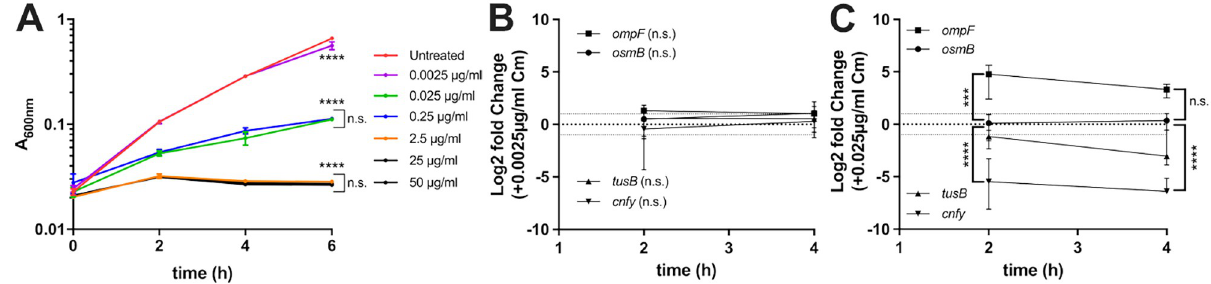
Fig 8. ompF , tusB , and cnfy are differentially regulated in response to inhibitory concentrations of chloramphenicol, while osmB expression was only altered by doxycycline. (A) WT Y . pseudotuberculosis was grown in the presence of the indicated concentrations of chloramphenicol (Cm). Growth was measured by absorbance (A 600nm ) at the indicated timepoints (hours, h). Bacteria were grown in the presence or absence of (B) 0.0025 μ g/ ml Cm or (C) 0.025 μ g/ml Cm. RNA was isolated after 2h and 4h exposure, and the indicated transcripts were detected by qRT-PCR. Fold change is relative to untreated cells (represented by a dotted line at a value of 1). Statistics: (A-C) Two-way ANOVA with Tukey’s multiple comparison test, comparisons made relative to untreated cells, comparisons between treatment conditions where indicated by brackets. In C, statistics represent treated vs. untreated comparisons for cnfy , and ompF compared to osmB , which did not change with treatment. ���� p < .0001, ��� p < .001, n.s.: not significant.